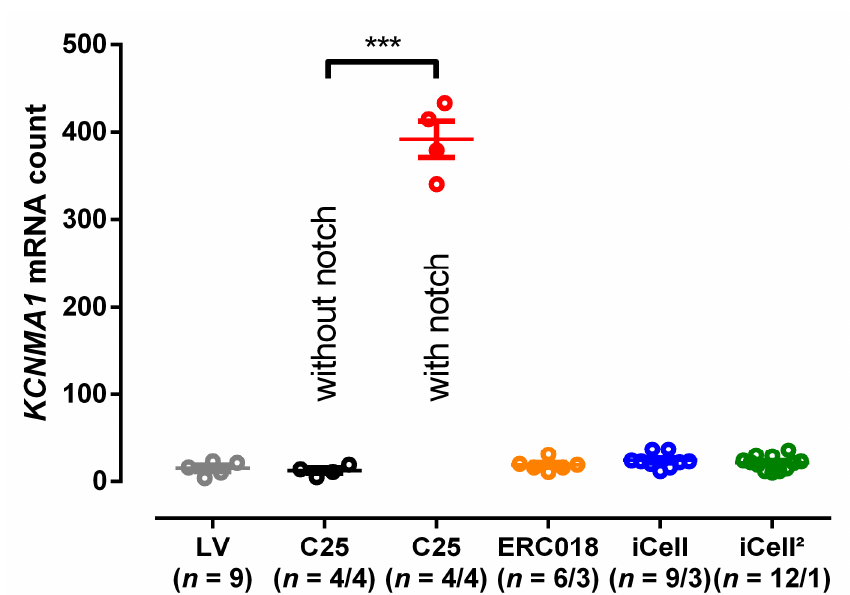
Figure 4. Expression analysis for the alpha subunit ( KCNMA1) of big conductance calcium activated potassium channel. Individual expression levels of KCNMA1 in left ventricular tissue (LV) and engineered heart tissue (EHT) from cell line C25 (without and with notch/oscillations), ERC018, iCell and iCell². Mean values ± SEM, *** p < 0.001, 1-way ANOVA with multiple comparison, n = number of patients for LV and n = number of EHT/number of individual differentiation batches.